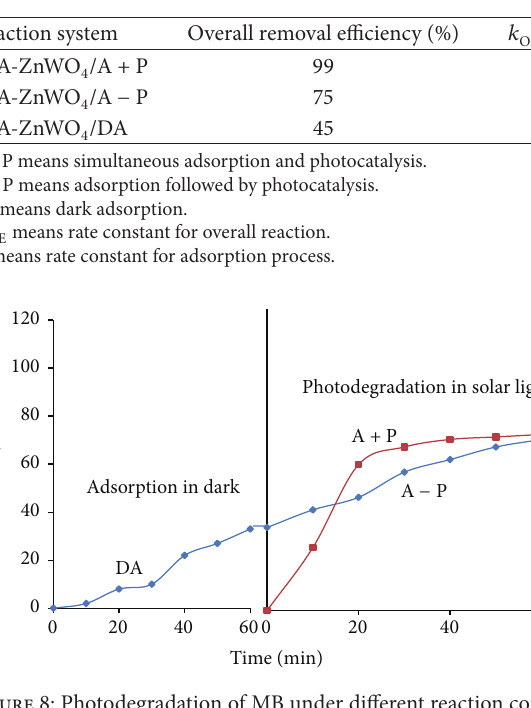
Table 1: Comparison of removal efficiency of BSA-ZnWO 50 mg/100mL, pH = 5, temperature: 30 ± 0.5 ∘ C.